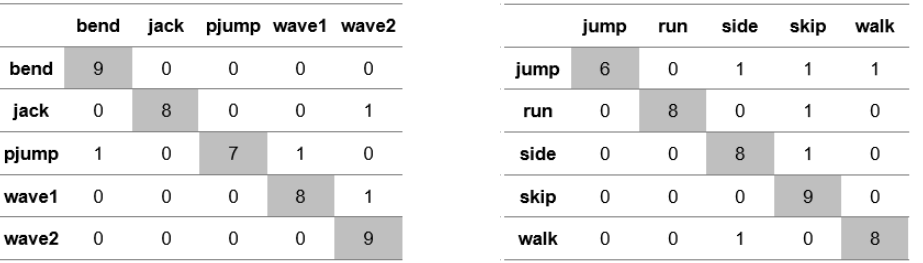
Figure 7. Confusion matrices for the best experiment using the original database without occlusions. ( Left table ): ‘actions performed in place’ subgroup, Perimeter, C1 correlation, 51 DFT coefficients, accuracy 91.11%. ( Right table ): ‘actions with changing location of a silhouette’ subgroup, Area, Euclidean distance, 31 DFT coefficients, accuracy